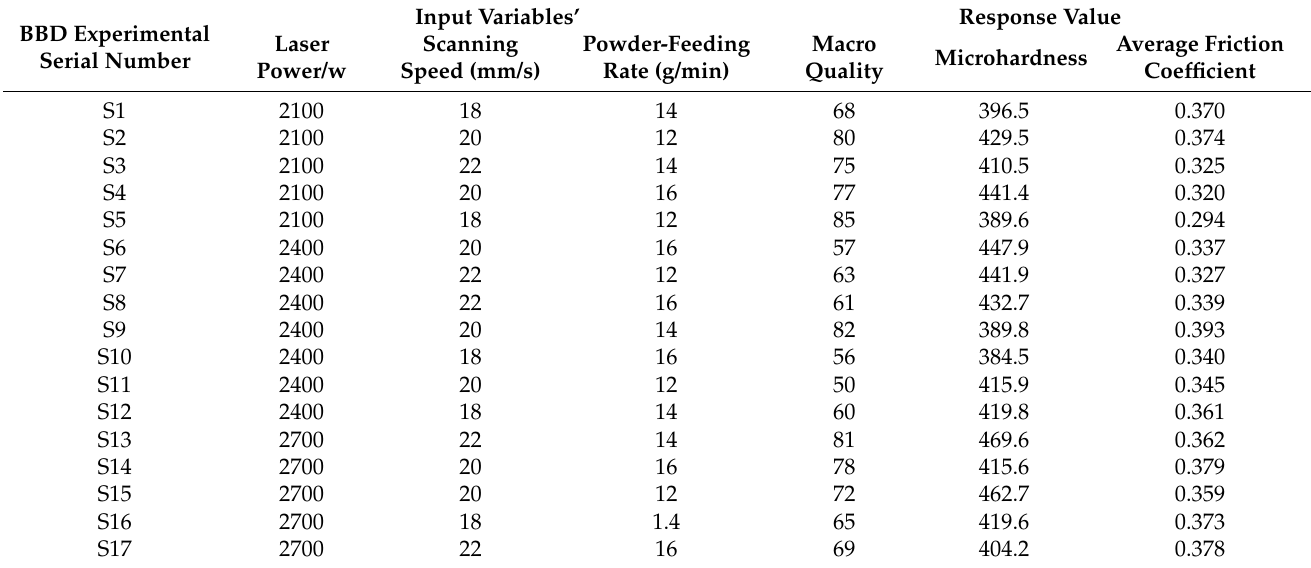
Table 2. Input variables and their response values for the BBD experimental